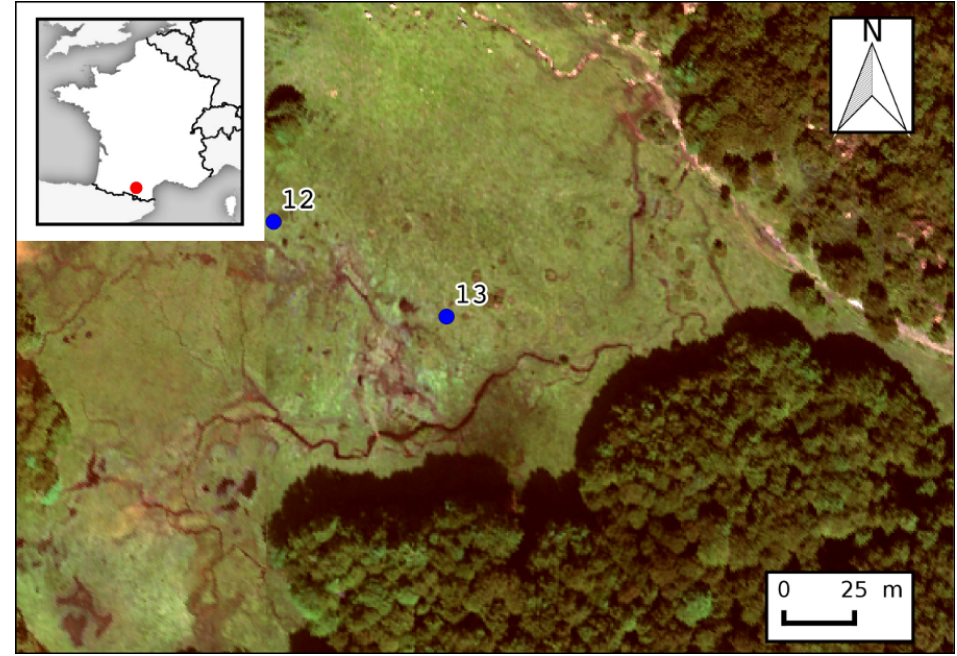
Figure A11. Location of the in situ spectroradiometer measurements for the plots of Juniperus communis